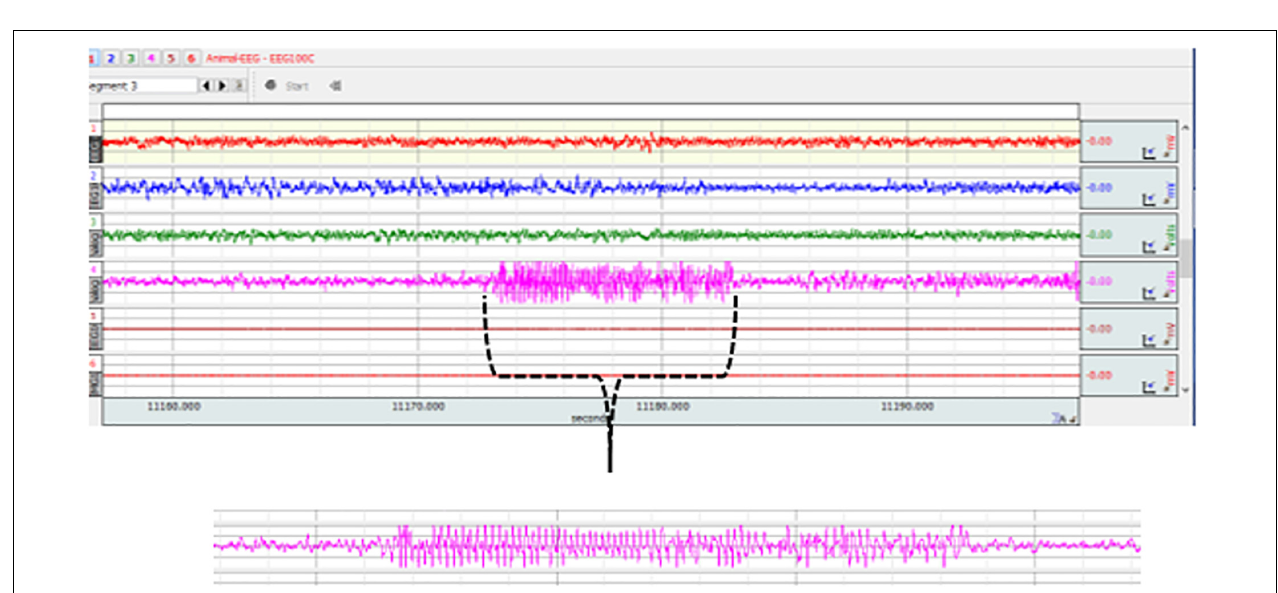
FIGURE 1 | A representative illustration of neonatal tactile stimulations. Light tactile stimulation (A) , deep touch pressure (B) .